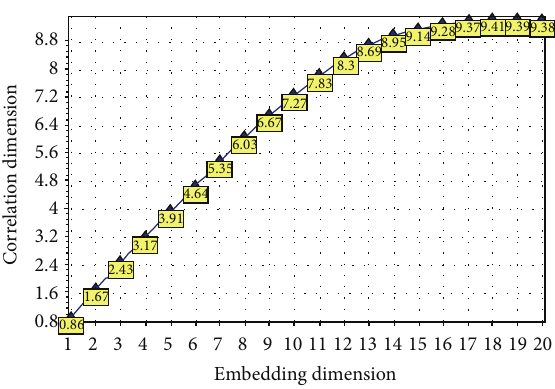
Figure 3: Evolution diagram of correlation dimension.